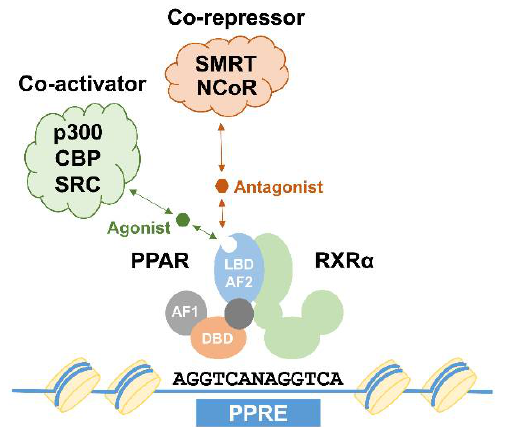
Figure 1. Transcriptional regulation by peroxisome proliferator-activated receptor (PPAR) proteins. PPARs form dimers with Retinoic acid receptor α (RXRα) proteins and subsequently bind to a DNA sequence known as peroxisome proliferator response elements (PPRE). Binding of agonists (green circle) or antagonists (red hexagon) lead to structural changes, enhancing co-activator (such as p300, CREB-binding protein (CBP), and Steroid receptor coactivator 1 (SRC1)) or co-repressor (such as Nuclear receptor corepressor (NCoR) and the Silencing mediator of retinoid and thyroid hormone receptor (SMART)) binding. AF1: activation function 1 domain; DBD: DNA-binding domain; LBD-AF2: ligand binding and activation function 2 domain.